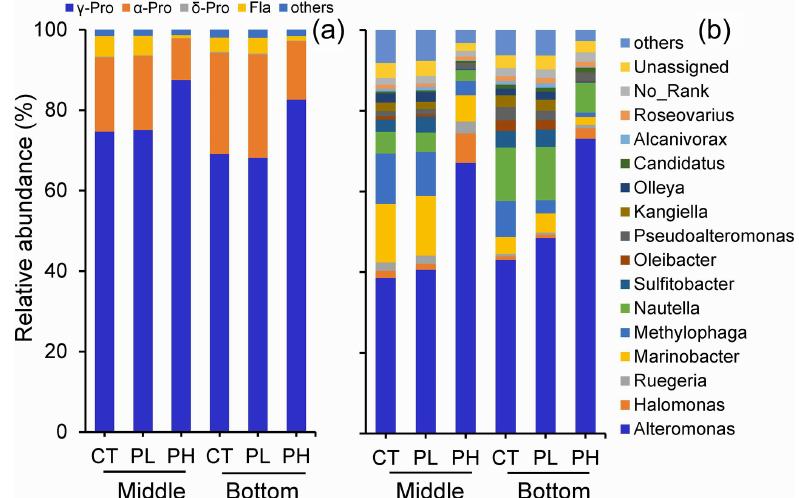
Figure 8. Variation of particle-attached bacterial community compositions on (a) the phylum level and (b) the genus level in response to different doses of PUA additions at the end of the experiments for the middle and the bottom waters at station Y1. Labels PL and PH are for the low- and high-dose PUAs with CT the